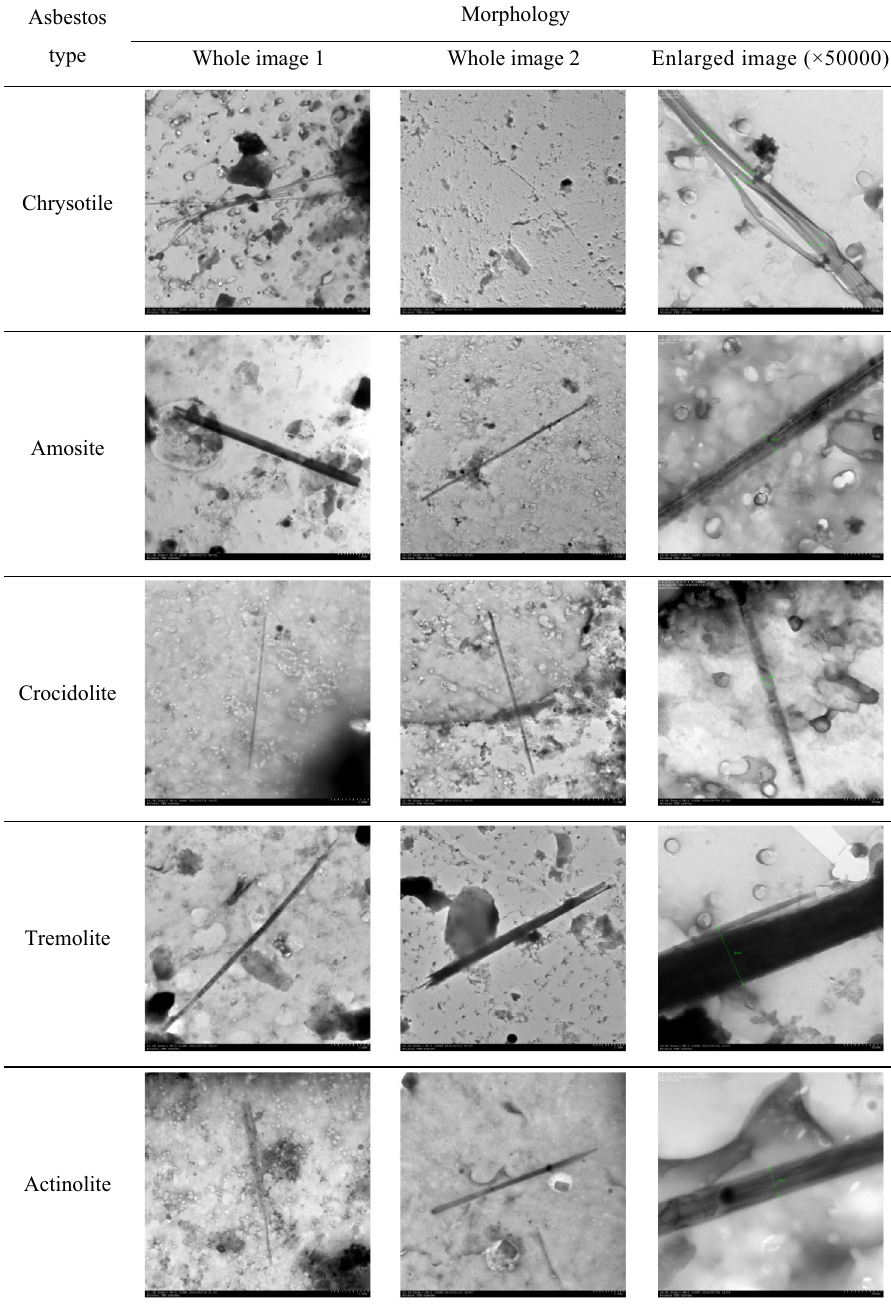
Table 6. Comparison of morphology of detected asbestos fibers in lung tissue between a whole image and an enlarged